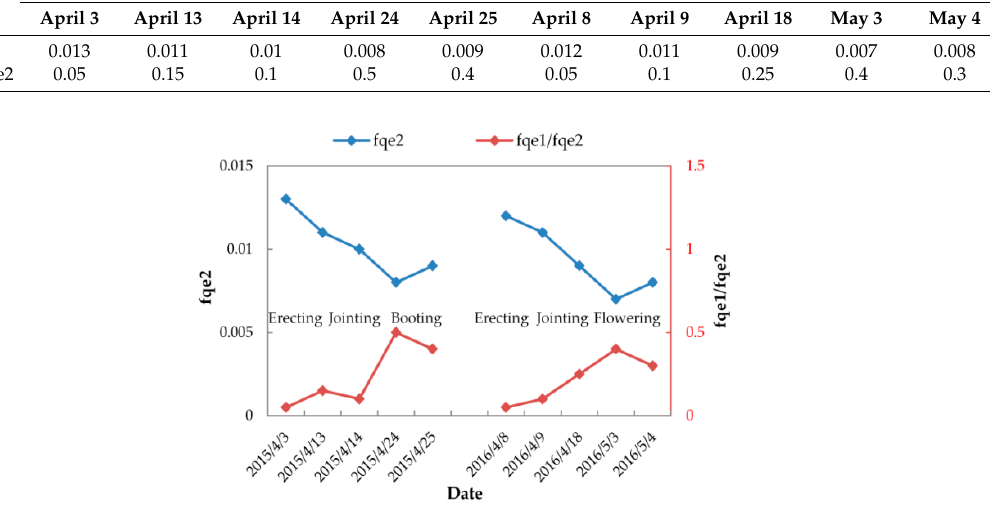
Figure 11. The seasonal cycles of fqe2 and fqe1/fqe2 on ten fieldwork days in 2015 and 2016.